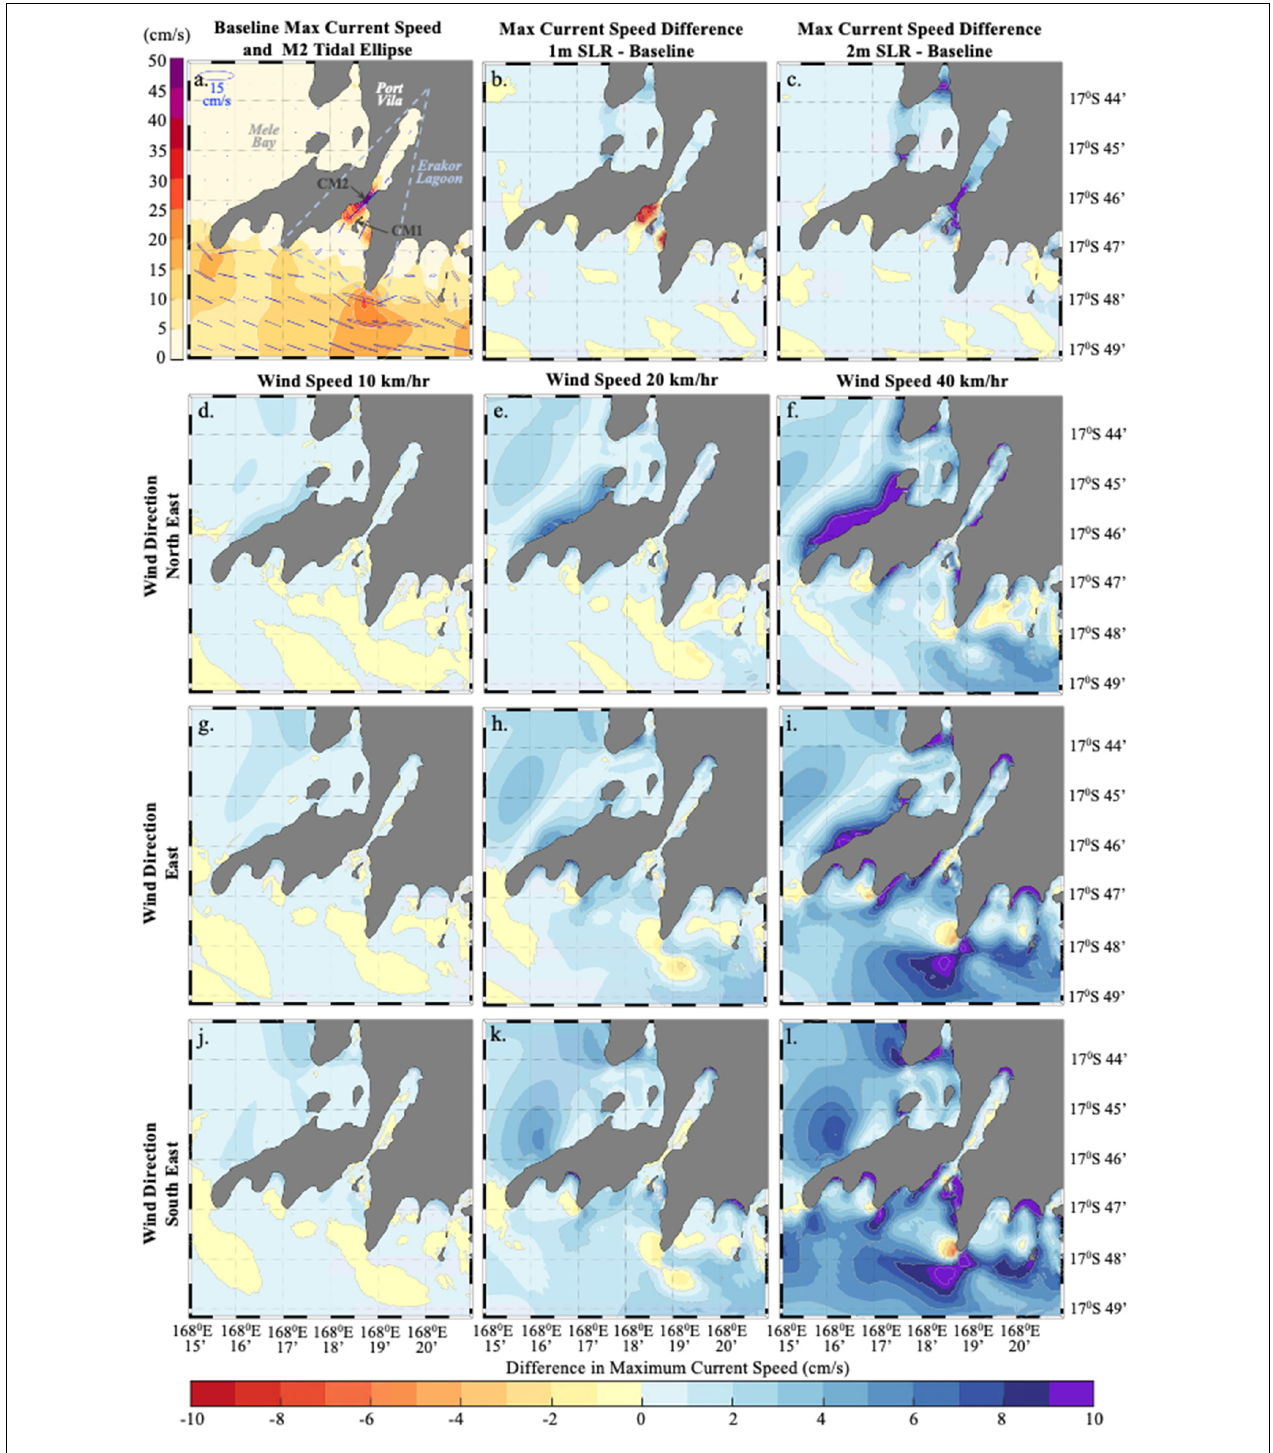
FIGURE 6 | Baseline maximum depth-averaged current speeds focussing on Erakor Lagoon, southwest Efate Island, shown underlying M2 tidal ellipses, with white isolines at 5 cm/s intervals (a) . Change in maximum depth-averaged current speeds (cm/s) under 1 m SLR (b) and 2 m SLR (c) . Change in maximum depth-averaged current speed (cm/s) under 10 km/h (d) , 20 km/h (e) , and 40 km/h (f) northeast winds. Change in maximum depth-averaged current speed under 10 km/h (g) , 20 km/h (h) , and 40 km/h (i) east winds. Change in maximum depth-averaged current speed under 10 km/h (j) , 20 km/h (k) , and 40 km/h (l) southeast winds. Light grey isolines (b–l) indicate 2 cm/s intervals. Latitudes are displayed to the right of panels (c,f,i,l) . Longitude for all panels are displayed below panels (j–l) .